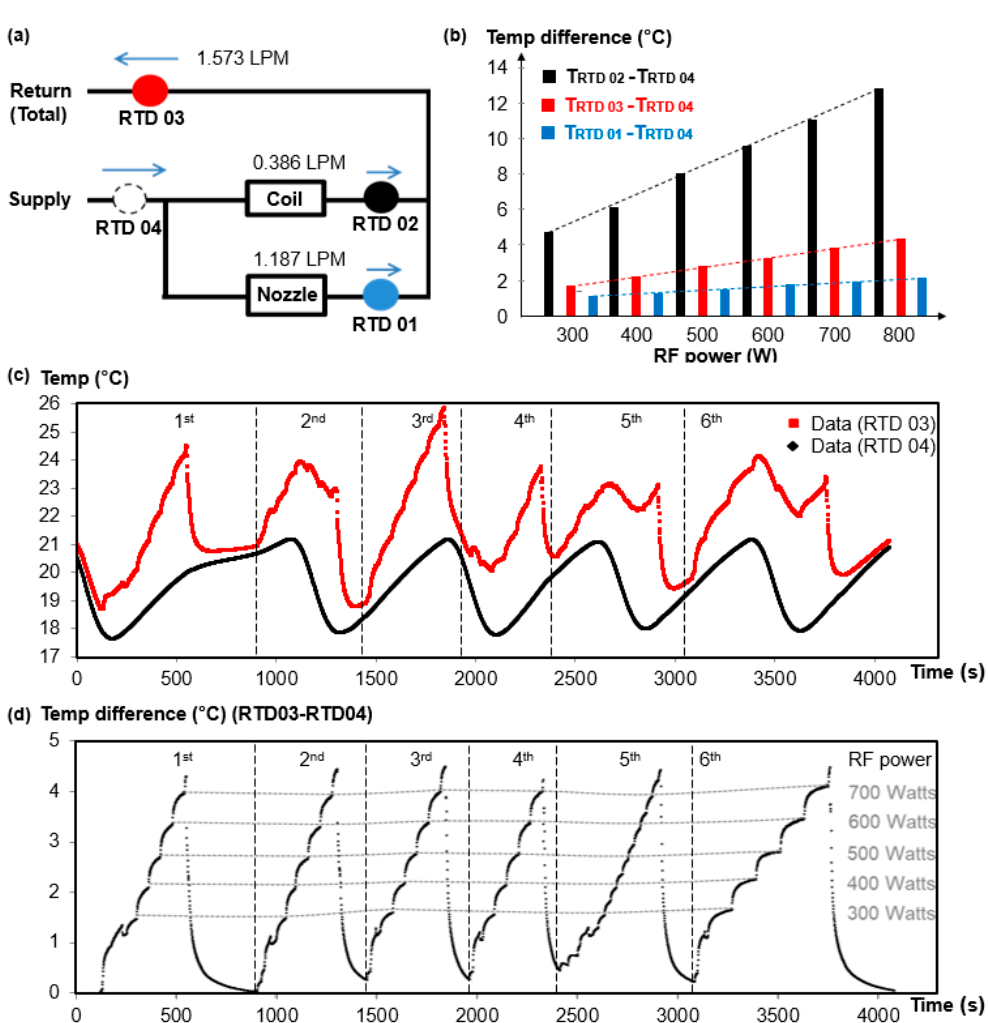
Figure 9. Schematic of coolant circuit and the temperature measurement data. ( a ) RTDs were positioned at four key points of the coolant circuit; ( b ) temperature difference of coolant channels: coil, nozzle and total; ( c ) original temperature reading logged from the RTD 03 and 04; ( d ) temperature difference between RTD 03 and 04.